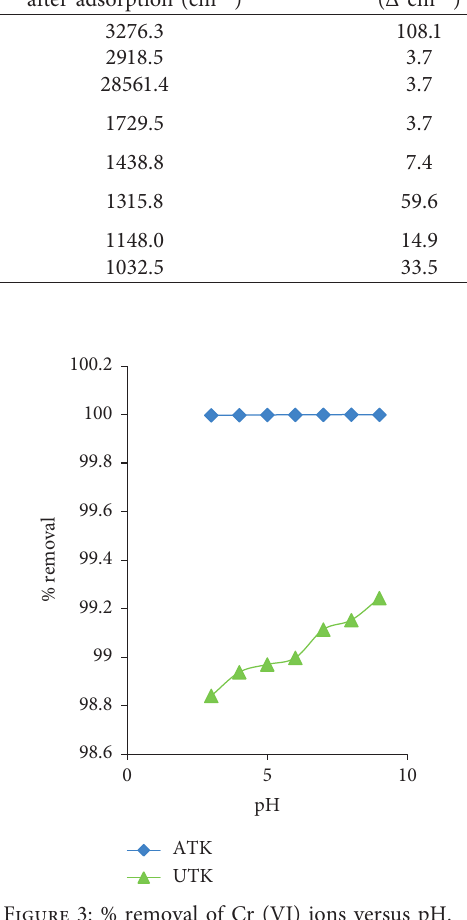
Table 1: FTIR analysis of cola nut leaves before and after adsorption with their corresponding functional groups [16]. Vibration peaks of cola nut leaves S/N before adsorption (cm − 1 )